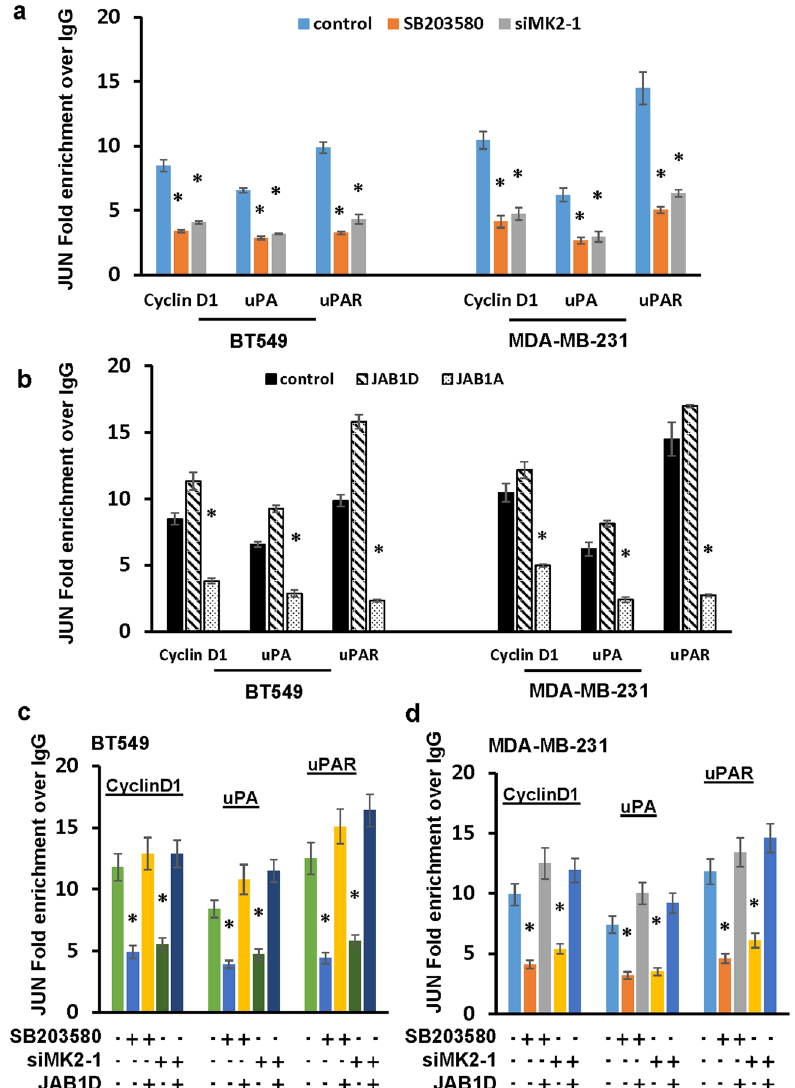
Fig. 6 Ser177 phosphorylation of JAB1 impacts JUN binding to AP1 sites. a BT549 or MDA-MB-231 cells were treated with 5 µM SB203580 for 1 day or 30 nM MK2 siRNA (siMK2-1) for 3 days for left untreated (control) and then subjected to JUN ChIP followed by qPCR to analyze JUN occupancy in cyclin D1, uPA and uPAR promoters. Data are means ± SD from three experiments. * P < 0.01 vs Control. b BT549 or MDA-MB-231 cells were transduced with JAB1D, JAB1A, or empty vector (control) for 3 days and then subjected to JUN ChIP followed by qPCR to analyze JUN occupancy in cyclin D1, uPA and uPAR promoters. Data are means ± SD from three experiments. * P < 0.01 vs Control. c , d BT549 ( c ) or MDA-MB-231 cells ( d ) were transduced JAB1D or empty vector for 3 days and then treated with 5 µM SB203580 for 1 day or 30 nM MK2 siRNA (siMK2-1) for 3 days followed by JUN ChIP to detect JUN occupancy in cyclin D1, uPA and uPAR promoters. Data are means ± SD from three experiments. * P < 0.01 vs